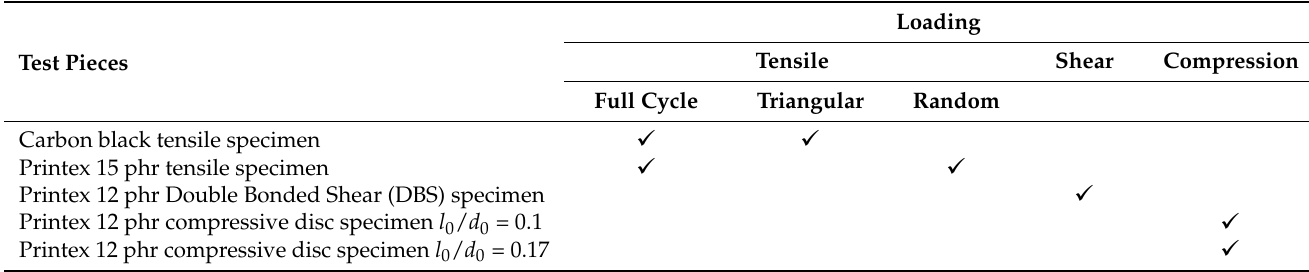
Table 2. Test pieces and loading conditions.